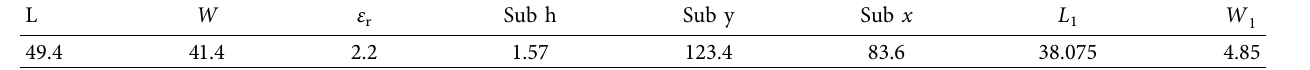
Table 1: Dimensions of the proposed fractal antenna in mm.